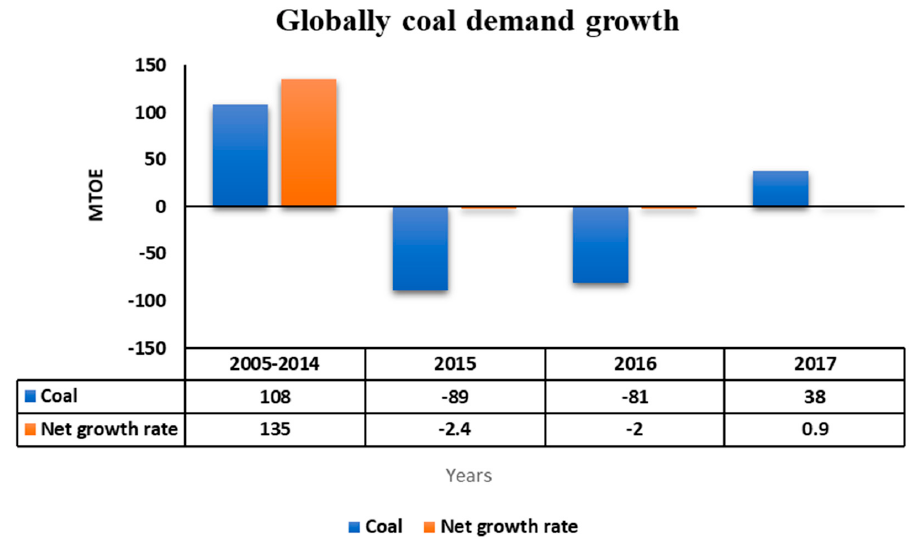
Figure 3. Production of fossil fuel in different nations along with India [11].